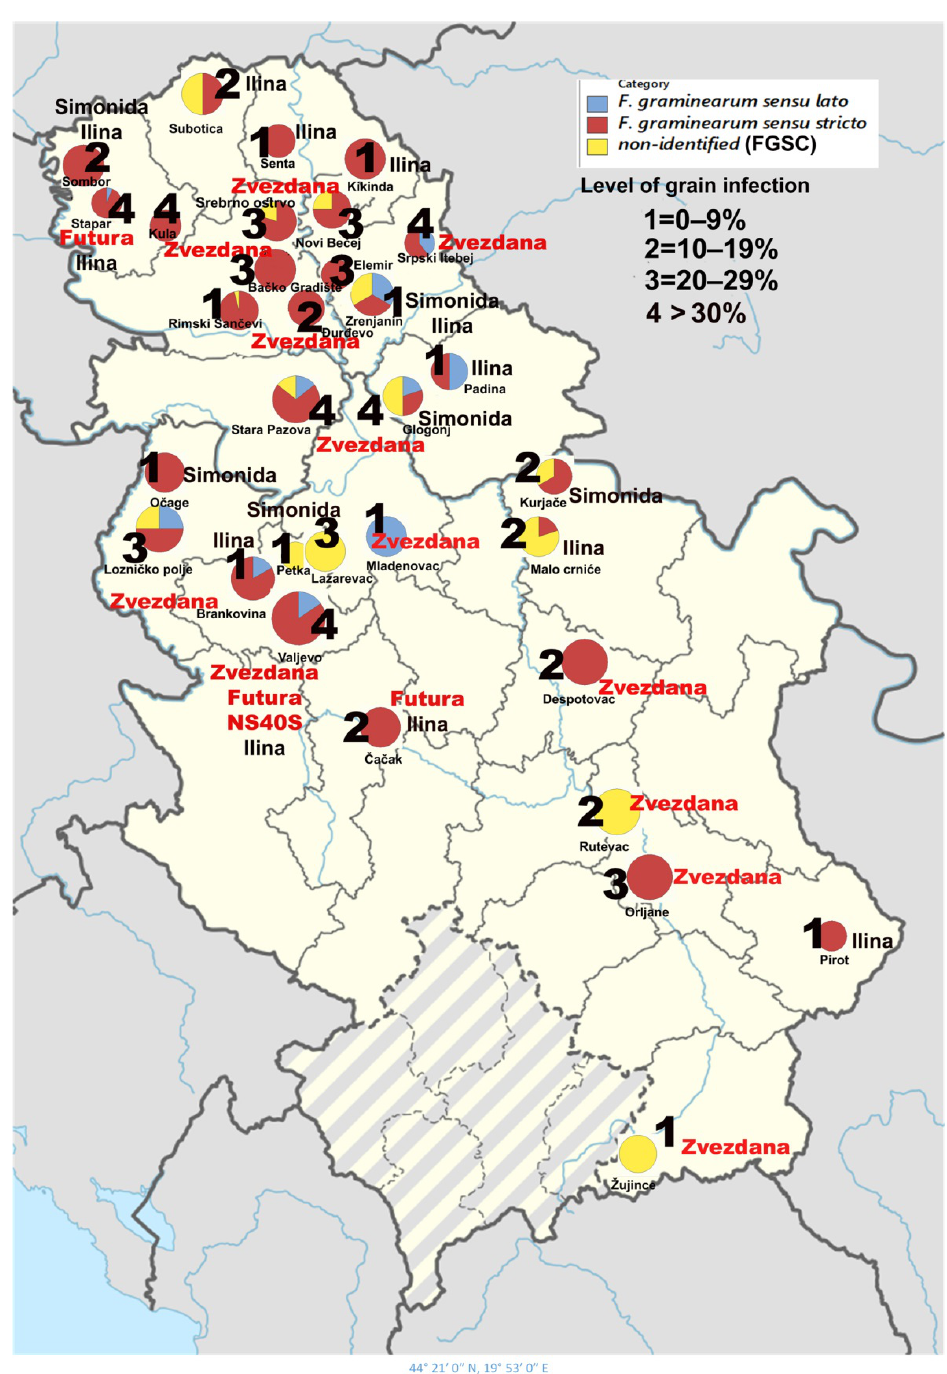
Figure 5. Geographic distribution of FGSC members and the levels of grain infection of five winter wheat varieties in a three-year period (2017–2019) in Serbia. MCA indicated that the first two dimensions contributed to 30% of the overall var- iability, and not all points were equally well explained by the two dimensions (Figure 6, Table S7). For some items, more than two dimensions were required to adequately rep- resent the data. These results indicate that multiple factors influence the association be- tween the predisposition for mycotoxin production and grain infection.